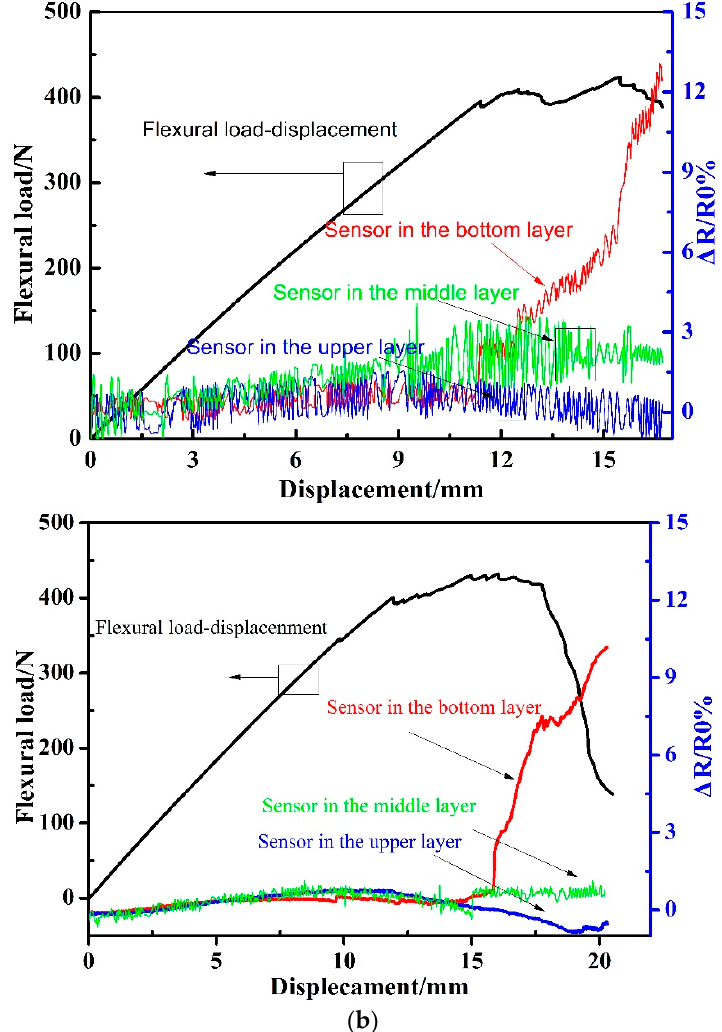
Figure 7. Resistance change of the MWCNT sensor in short beam shear and flexural tests of the unidirectional composite laminates. The repeat curve is also given in the figure. ( a ) Short beam shear and the parallel sample. ( b ) Flexural and the parallel sample